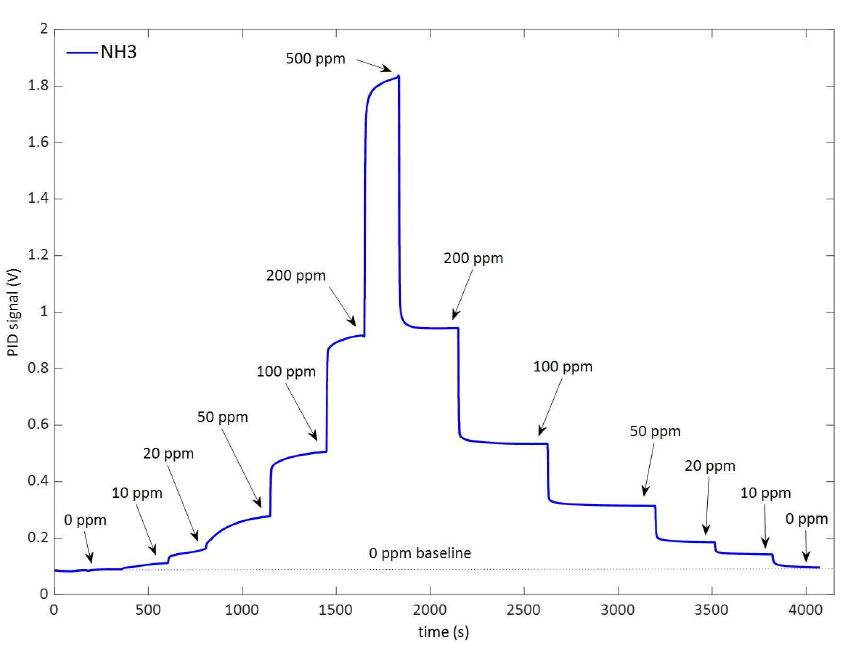
Figure 8. Response of the PID following the variation over time of the concentration of ammonia.